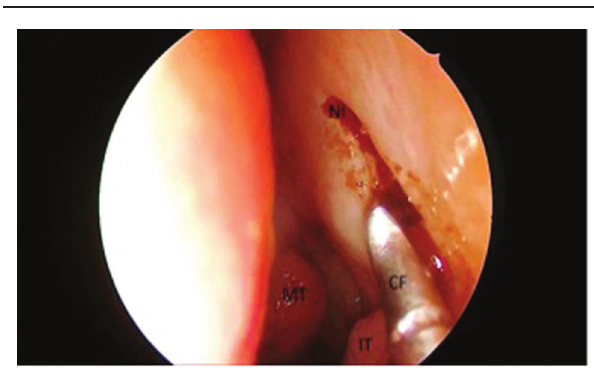
Nasal mucosal incision: Cottle elevator used to create nasal mucosal flap in shape of reverse-c. CF: Cottle elevator, IT: inferior turbinate, MT: middle turbinate, NI: nasal incision.